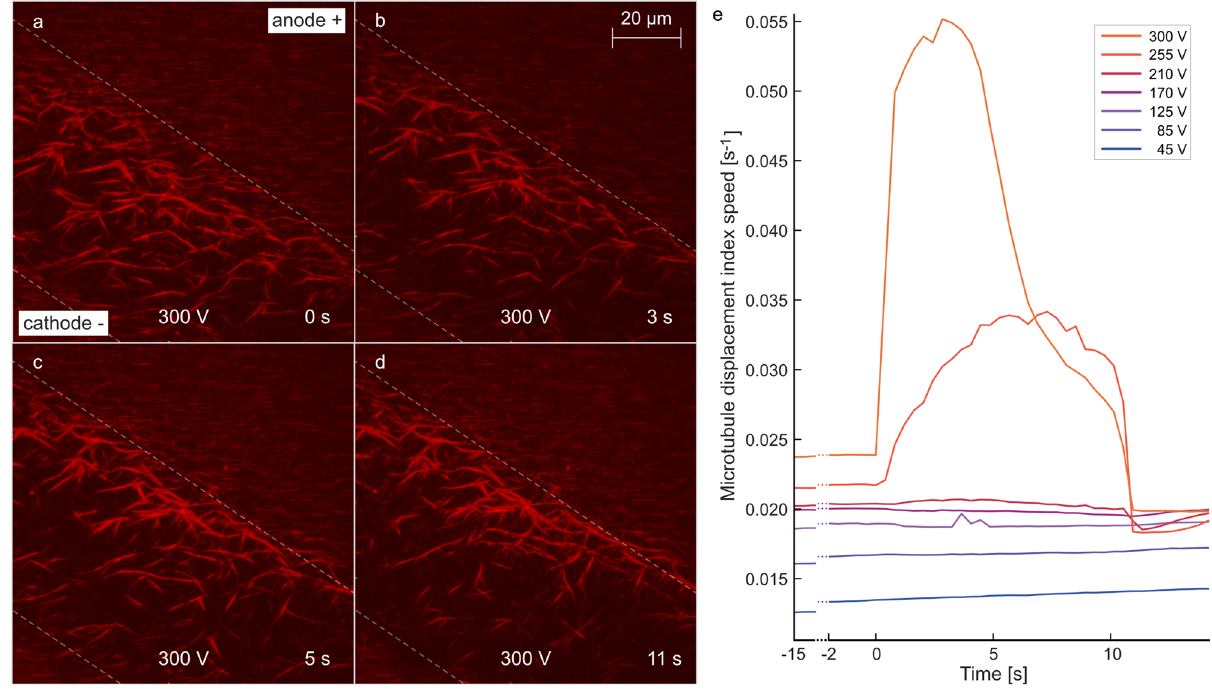
Figure 4. Time dependence of MT displacement by a sequence of electric pulses (5 µ s, N=100 pulses, 10 Hz firing frequency). (a) – (d) snapshots of fluorescently (red) labeled MTs during the firing of electric pulses at 300 V, (e) Microtubule displacement index speed depicting the displacement speed for each pulse voltage setting